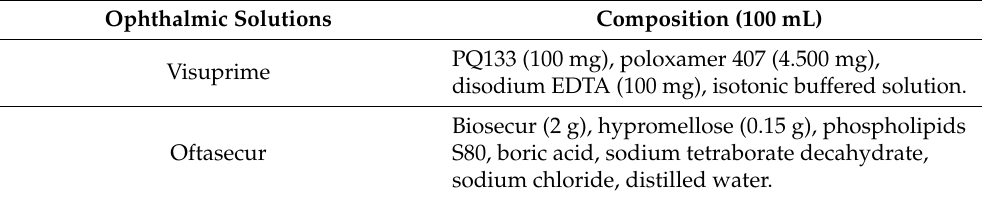
Table 1. Compositions of the ophthalmic solutions. Ophthalmic Solutions Composition (100 mL) PQ133 (100 mg), poloxamer 407 (4.500 mg), Visuprime disodium EDTA (100 mg), isotonic buffered solution. Biosecur (2 g), hypromellose (0.15 g), phospholipids Oftasecur S80, boric acid, sodium tetraborate decahydrate, sodium chloride, distilled